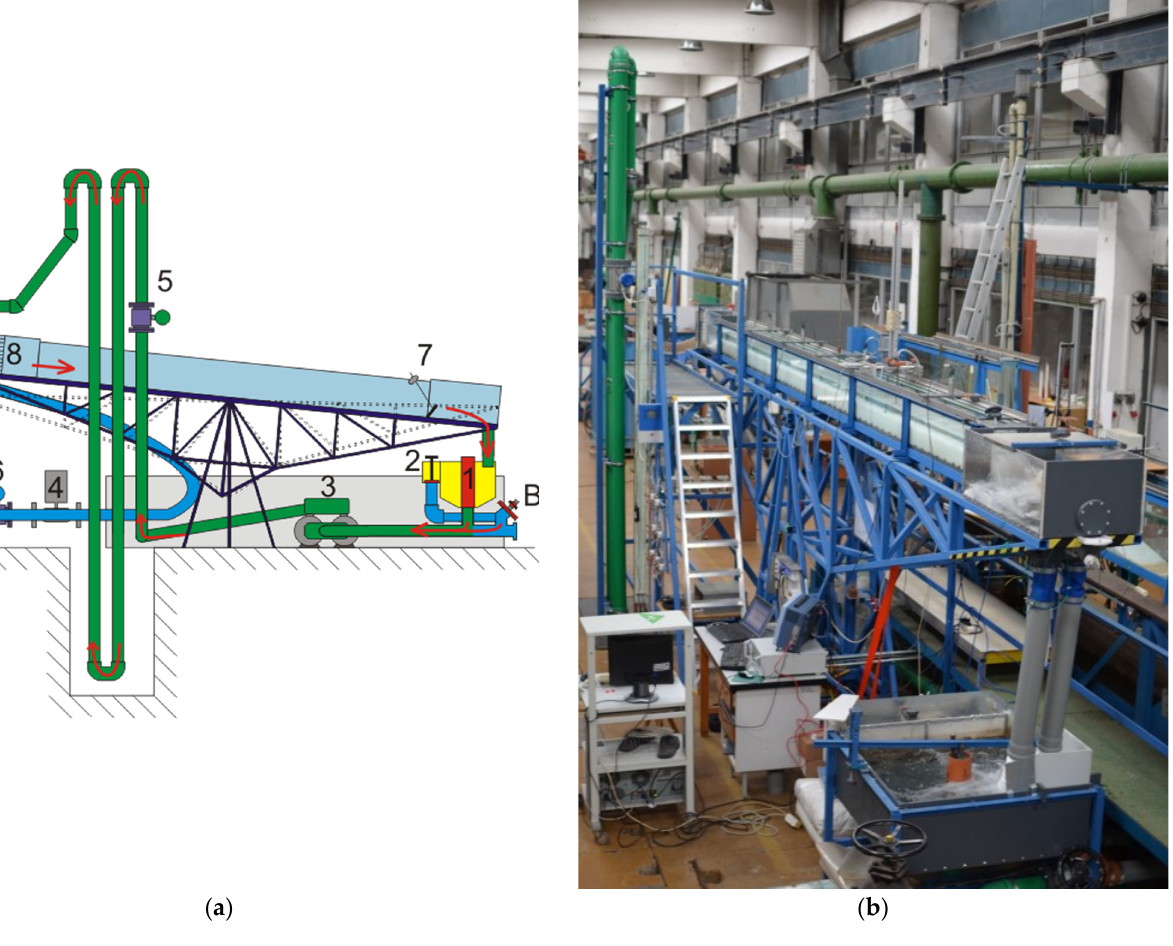
Figure 2. Experimental set-up in Water Engineering Laboratory: ( a ) Lay-out of the recirculating system with tilting flume; ( b ) Overall view of recirculating system [26].